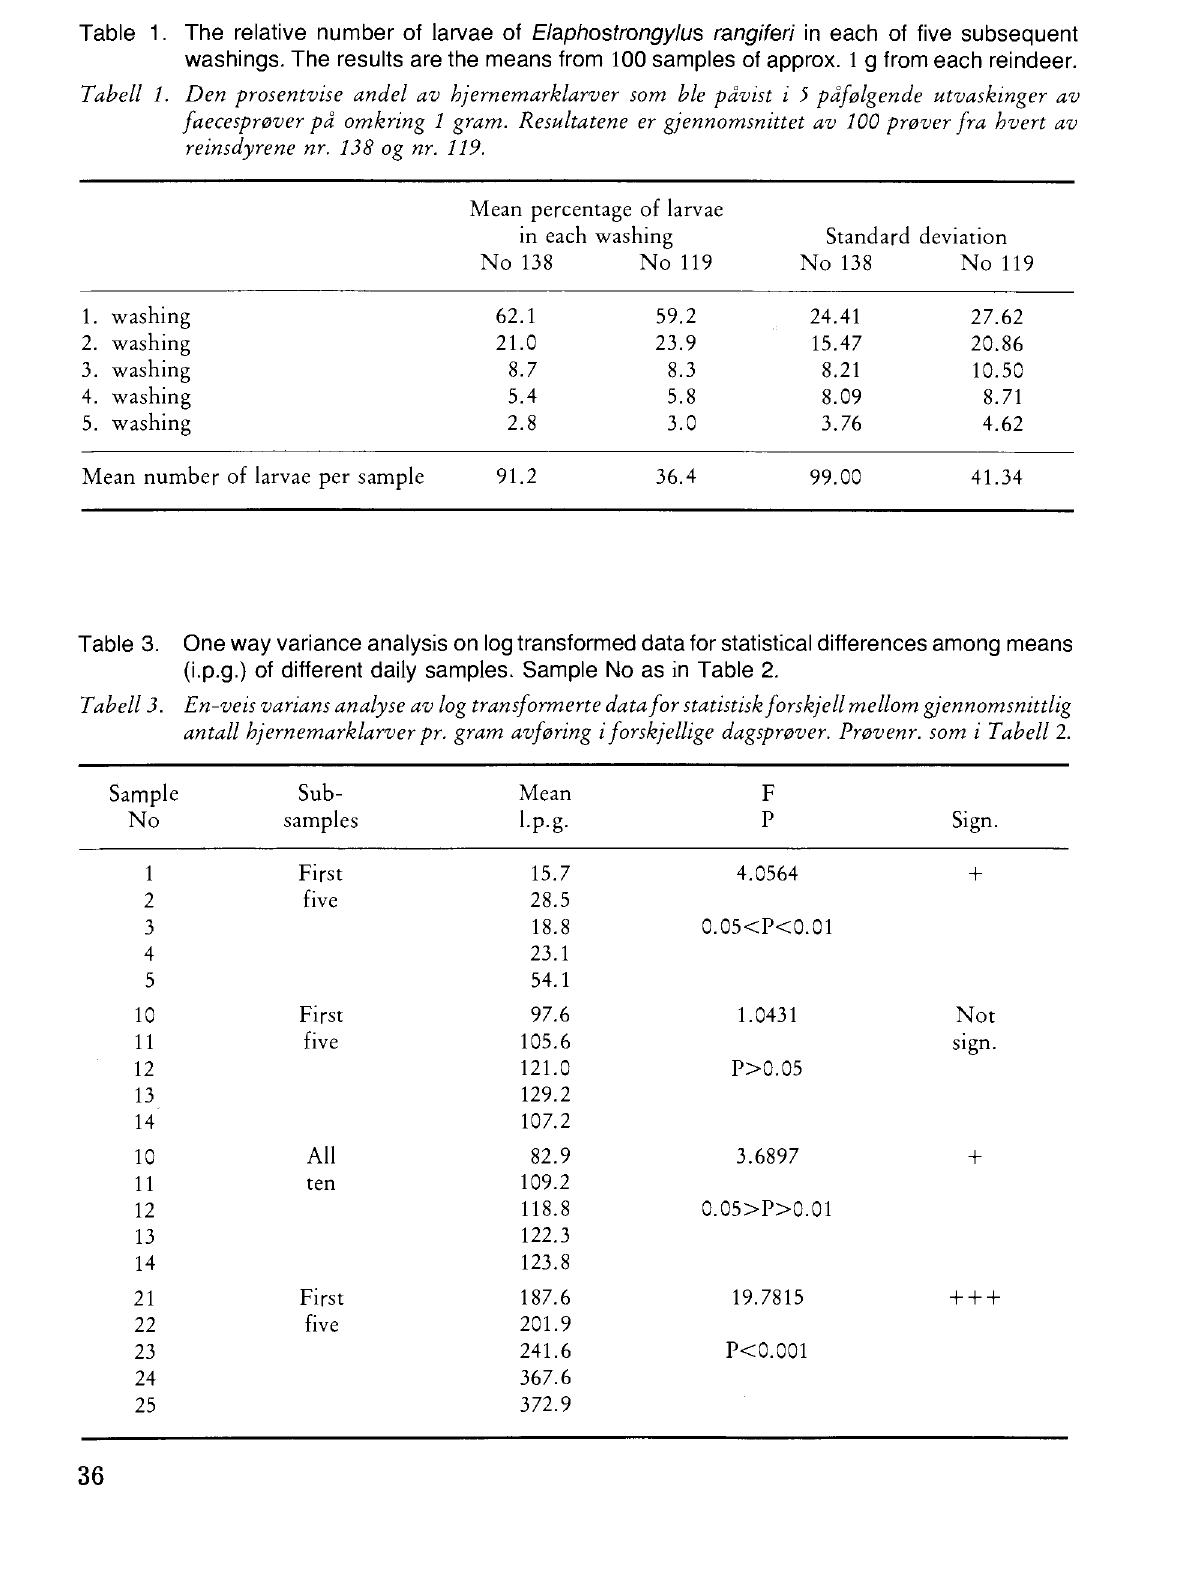
One way variance analysis on log transformed data for statistical differences among means (i-p.g) of different daily samples. Sample No as in Table 2. Tabell 3. En-veis varians analyse av k ig transformerte data for statistisk